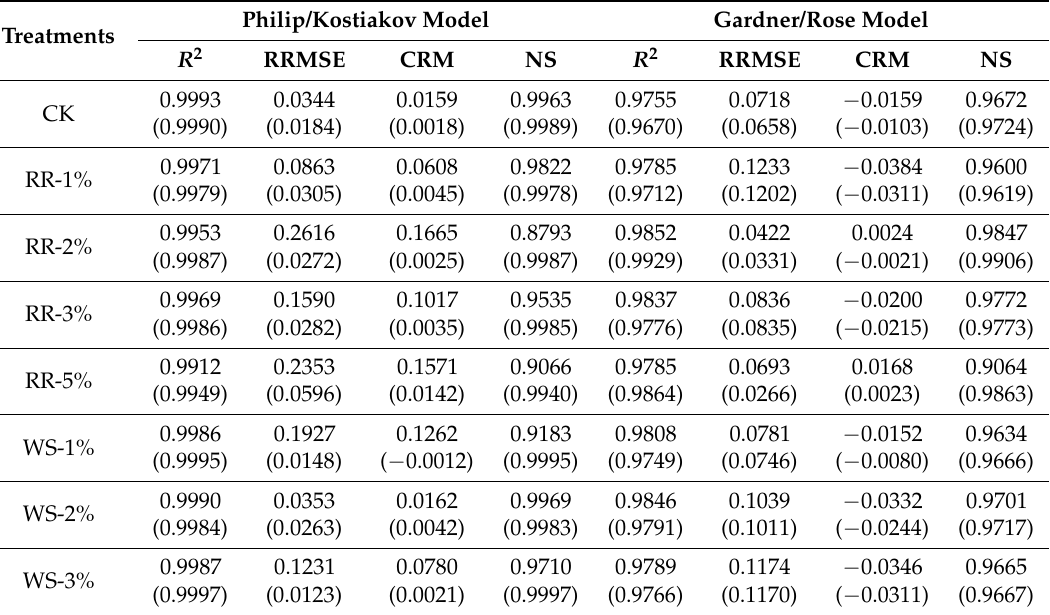
Table 2. Error analysis of Philip, Kostiakov, Gardner, and Rose models. Treatments